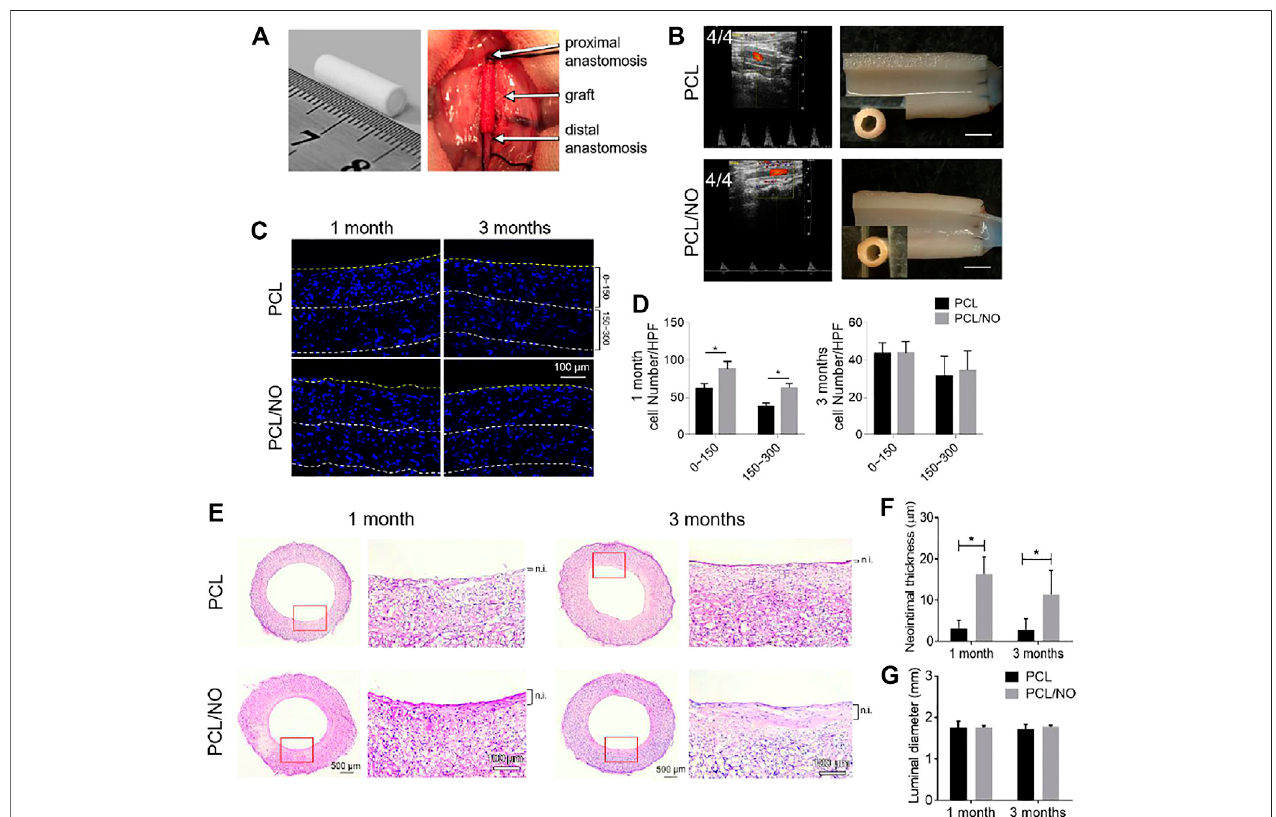
FIGURE 2 | In vivo performance of SDVGs in abdominal aorta replacement rat models. (A) Photographic representation of fabricated grafts (left) and surgical implantation and anastomosis of SDVGs in rat abdominal aortae (right) . (B) High-resolution ultrasound imaging of implanted SDVGs at 3 months, patency rating inset (left panels) . Longitudinally cut transections of SDVGs and observation by stereomicroscope, inset panels are stereomicroscope images of enface cross-sections before transection, scale bars (cid:1) 2 mm (right panels) . (C) DAPI stained sections of SDVGs at 1- and 3-months post-implantation to visualize cell in fi ltration at 0 – 150 μ m and 150 – 300 µm graft depths. Yellow dashed line indicates the graft lumen surface, white dashed lines indicate 150 and 300 µm depths from the lumen surface. Scale bar (cid:1) 100 µm. (D) The average cell number per high-powered fi eld (HPF) within different SDVG depths at 1 month (left) and 3 months (right) . (E) H&E staining of enface SDVG sections. Scale bars (cid:1) 500 µm. Red boxes indicate the view shown in zoomed images alongside each panel. Scale bars (cid:1) 100 µm. The neointima (n.i.) is labeled alongside zoomed panels. Calculated (F) average neointimal thickness and (G) luminal diameter of PCL and PCL/NO SDVGs at 1- and 3- months post-implantation. Images and data are representative of n (cid:1) 4 independent